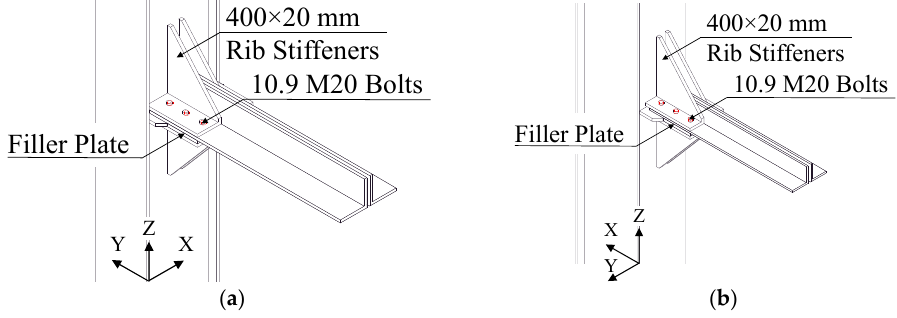
Figure 7. Local retrofit solutions on MR joints in both X- ( a ) and Y-directions ( b